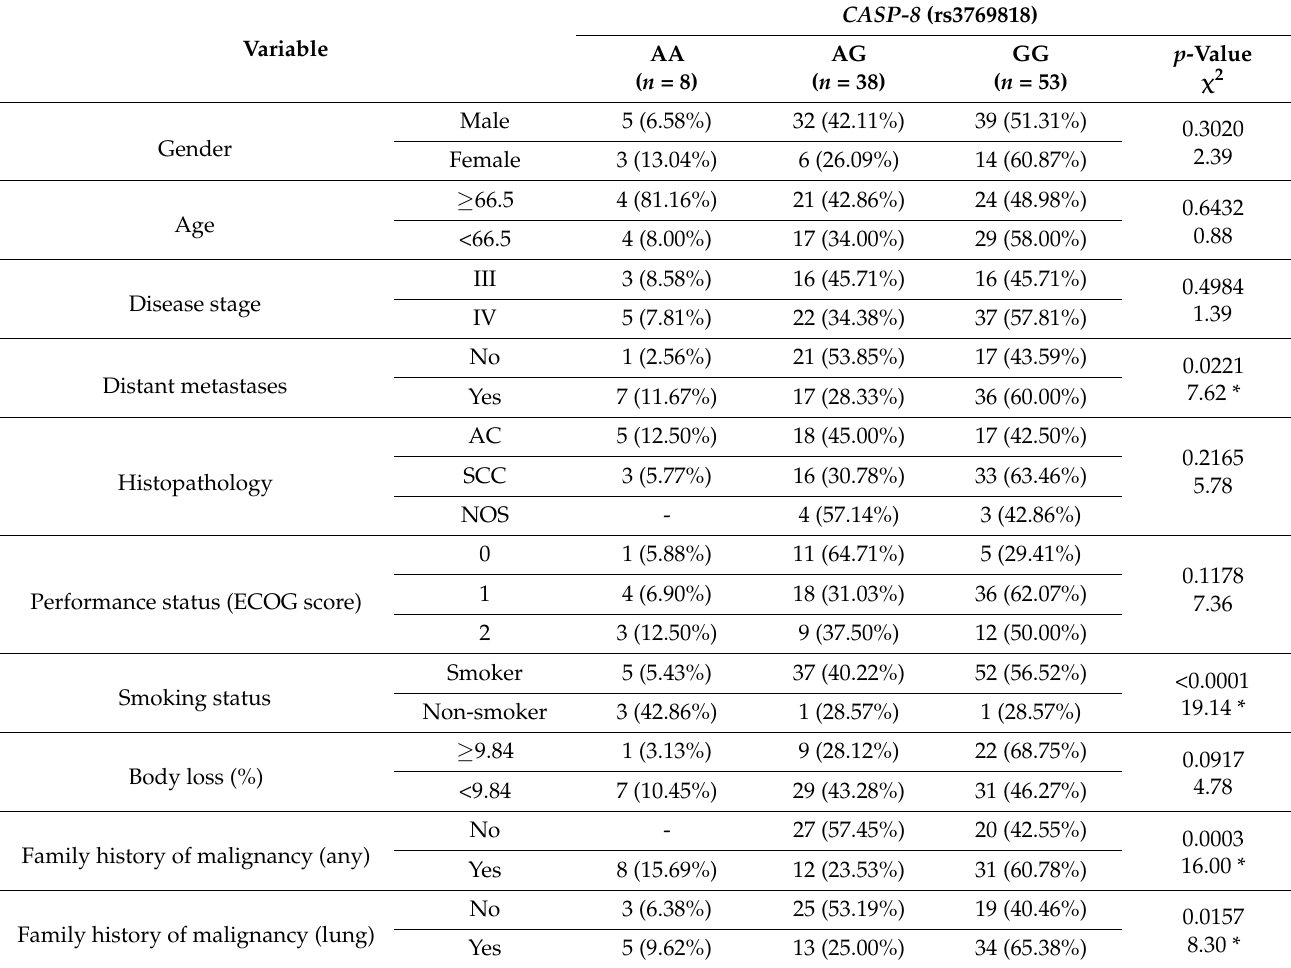
Table 2. Distribution of CASP-8 genotypes according to demographic and clinical